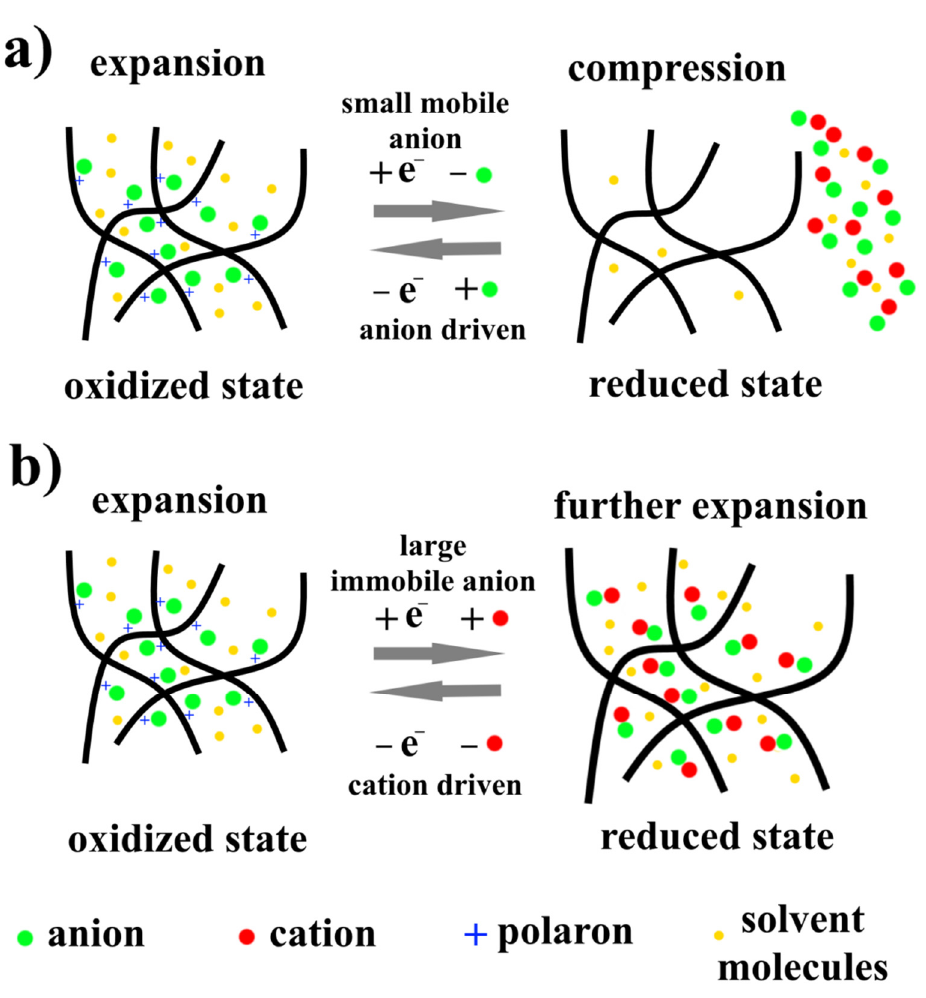
Figure 18. Ionic actuation mechanisms of conductive polymer actuators depending on the anion size and mobility: ( a ) small anion mobile, ( b ) large and immobile anion.